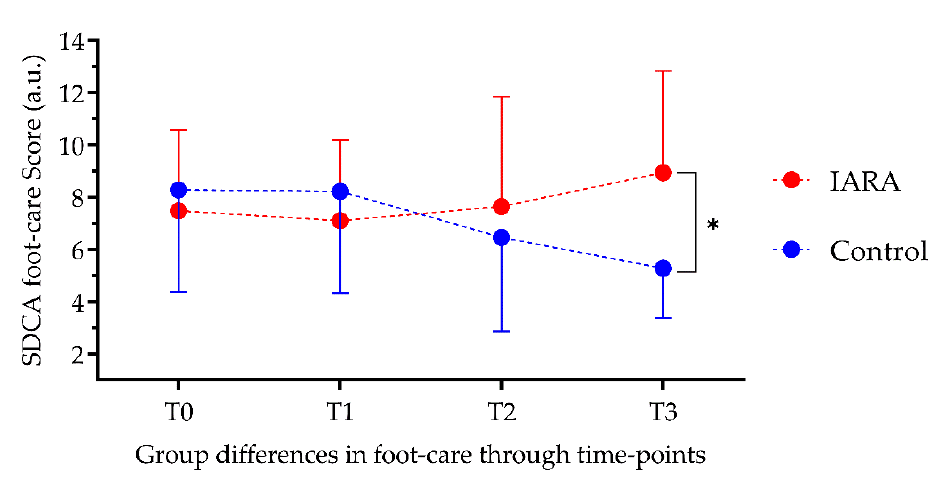
Figure 4. People who followed the IARA model demonstrated better compliance in blood glucose monitoring compared to Control. SDCA BGM — Italian Summary of Diabetes Self-Care Activi- ties/blood glucose monitoring; T0 — baseline; T1 — 3-month follow-up; T2 — 6-month follow-up; T3 — 12-month follow-up; * — p < 0.05.